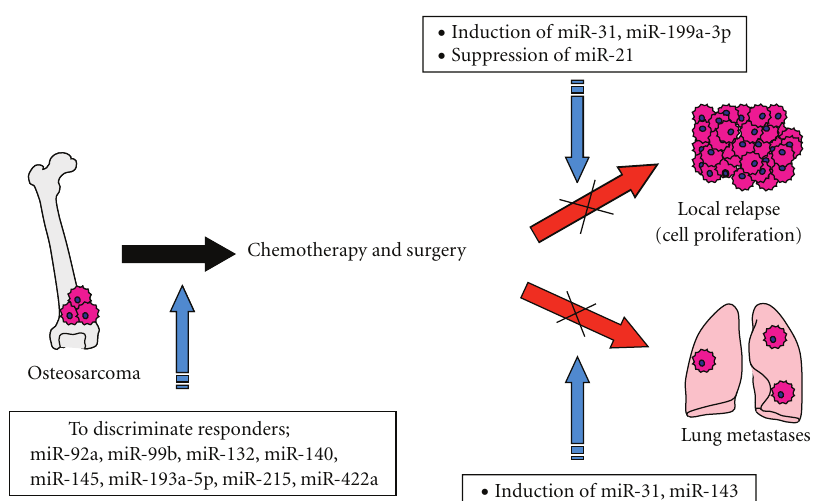
Figure 2: Potential candidate miRNAs to be used as biomarkers and therapeutic targets for